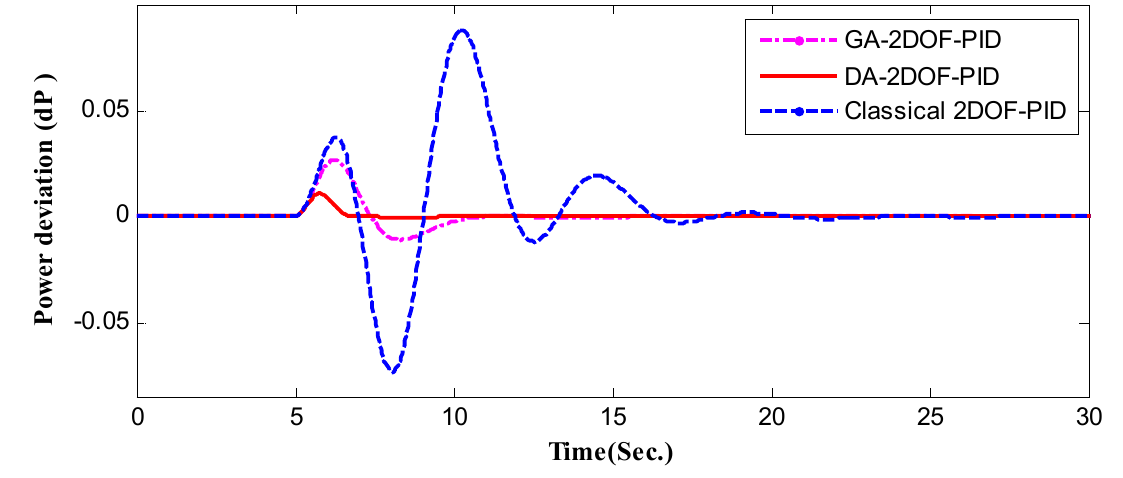
Figure 25. Δf (cid:2870) using GA-2DOF-PID, DA-2DOF-PID, and classical-2DOF-PID with IB-WGFF.